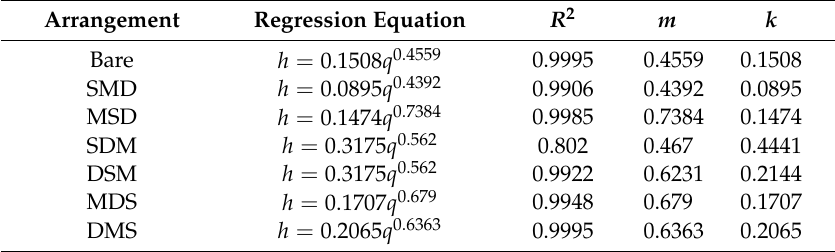
Table 3. Values of the flow-state indicator m and k in the different experimental groups.